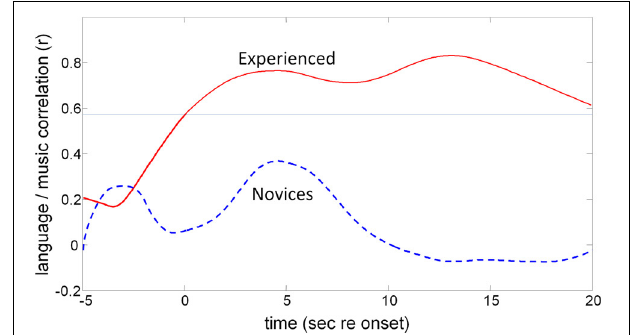
FIGURE 12 | The effect of previous musical training on CBFV correlation patterns. The two traces show the results of the moving cross-correlation between CBFV signatures for CWG and music synthesis. The top trace shows the (significant) correlation in blood-flow patterns for experienced musicians while novices (lower trace) do not show significantly correlated activity at any point of execution of the two tasks. The faint horizontal line shows the p = 0 . 05 significance threshold for the experienced